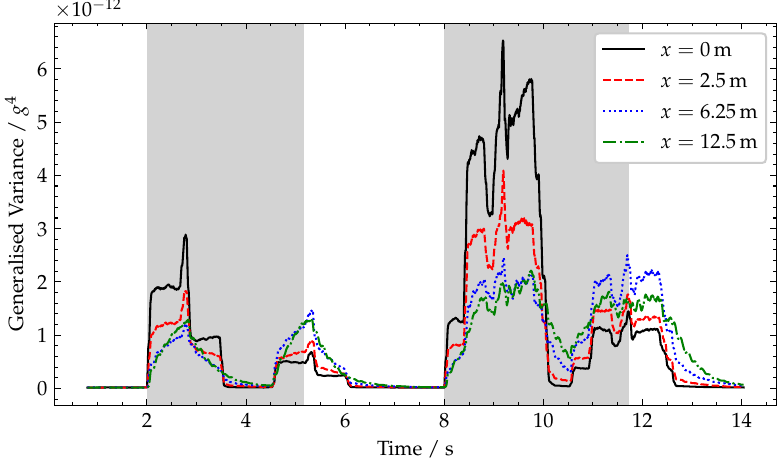
Figure 10. Plot of generalised variance for varying sensor locations, x . Periods when a vehicle is crossing the bridge are shaded